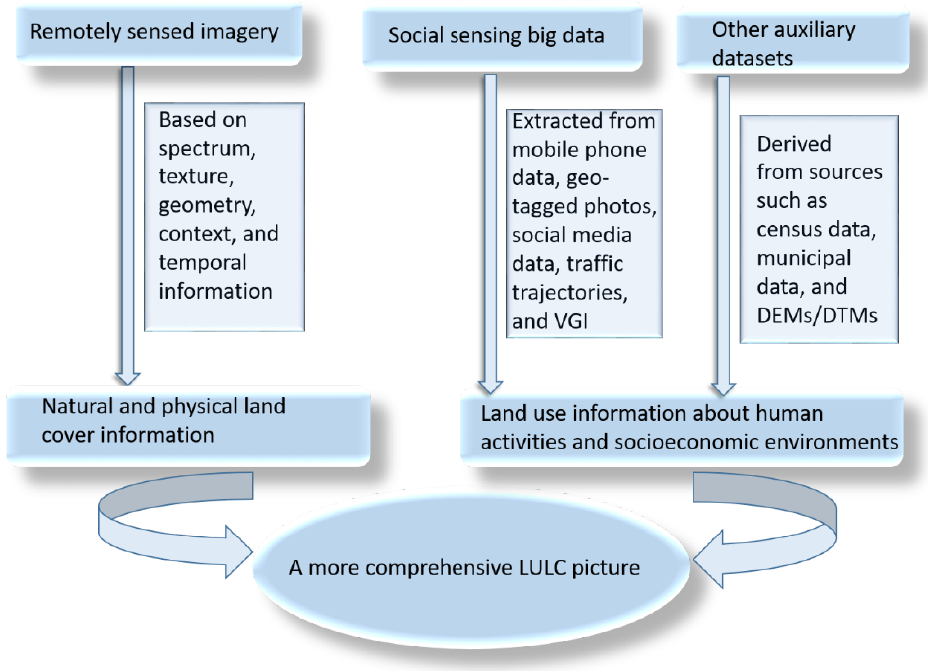
Figure 4. LULC mapping from the integration of geospatial big data and remotely sensed data.